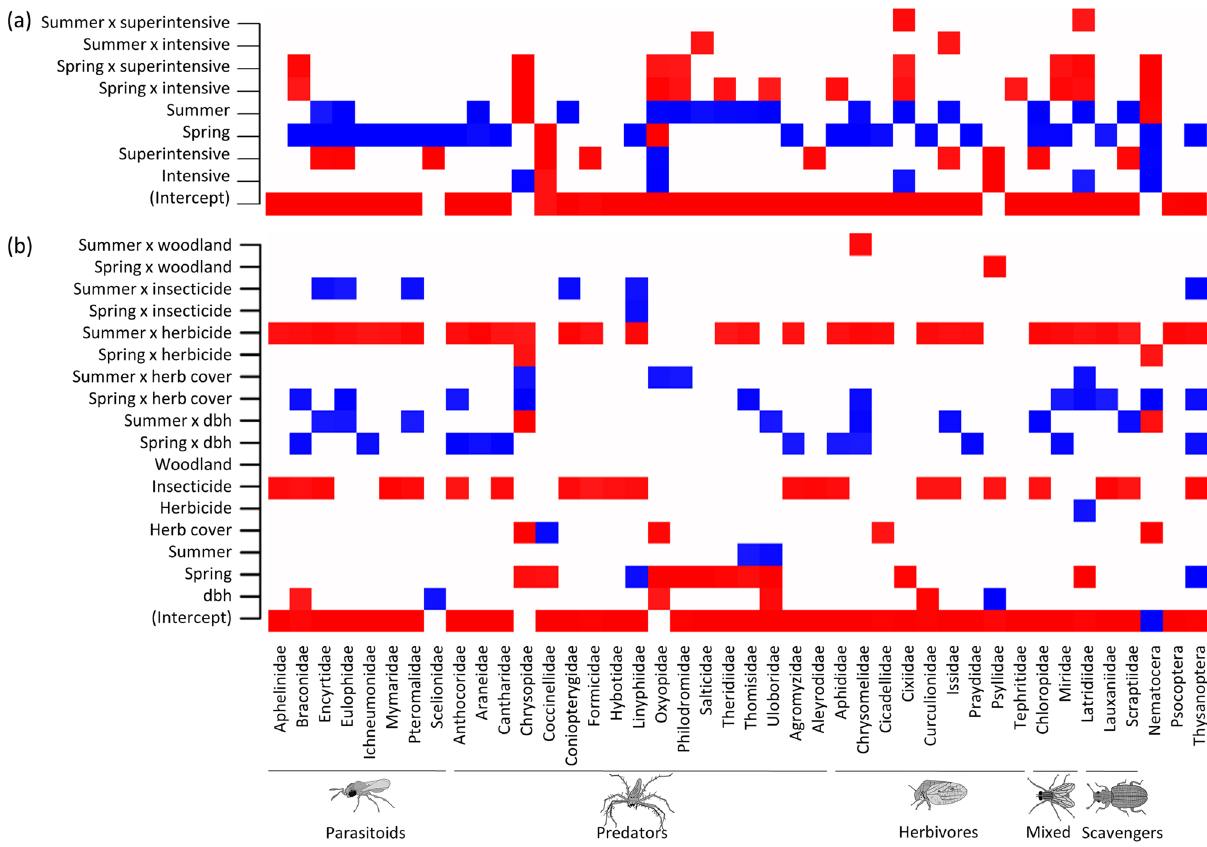
Figure 5. Heatmaps of effects (posterior estimates of β obtained from Hierarchical Modelling of Species Communities) of orchard intensification level, season, and their interaction ( a ), and of structural, management and landscape variables, and their interactions with season ( b ) on individual taxon abundance. The represented responses received high statistical support (posterior probability > 95%) of being positive (blue) or negative (red). Arthropod drawings by Juan Pablo